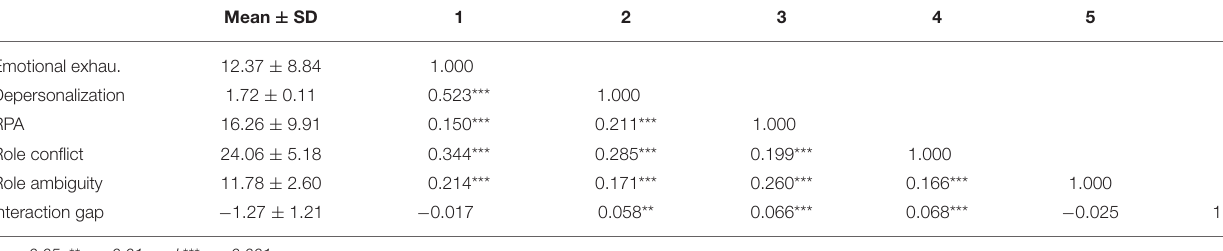
TABLE 3 | Means, SDs, and correlations for all variables in SEM of the Non-front-line sample. Mean ± SD 1 Emotional exhau.